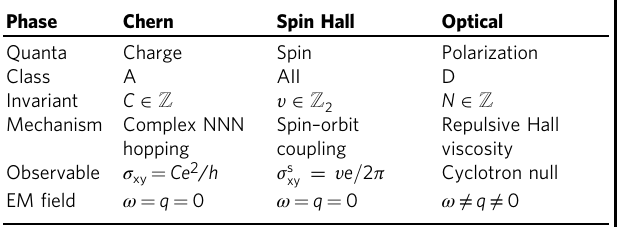
Table 1 Summary of the 2 + 1D topological phases in